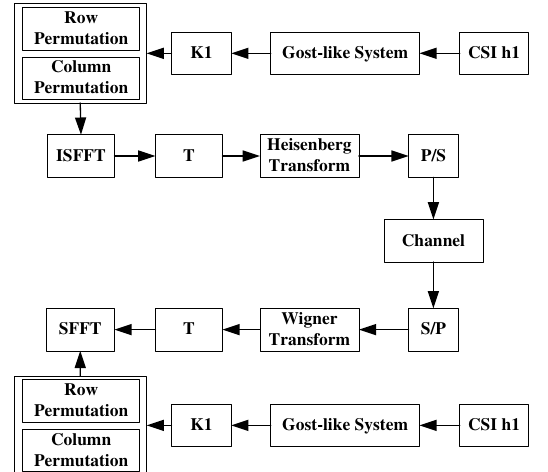
Figure 1. Flowchart for 2D permutation-aided OTFS secure